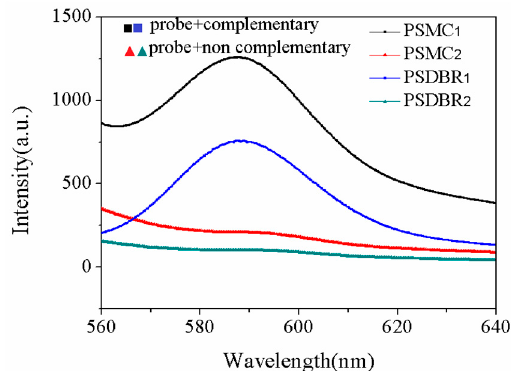
Figure 10. The fluorescence spectra of RRA-DNA detected on PSi biosensor. The concentration of RRA-DNA is 1 µM. There are two spectra from two different samples for one kind of sensor. One of the spectra is the fluorescence spectrum for the detection of complementary probe DNA (the solid square), and the other one is the spectrum for the detection of non complementary probe DNA (the solid regular triangle).